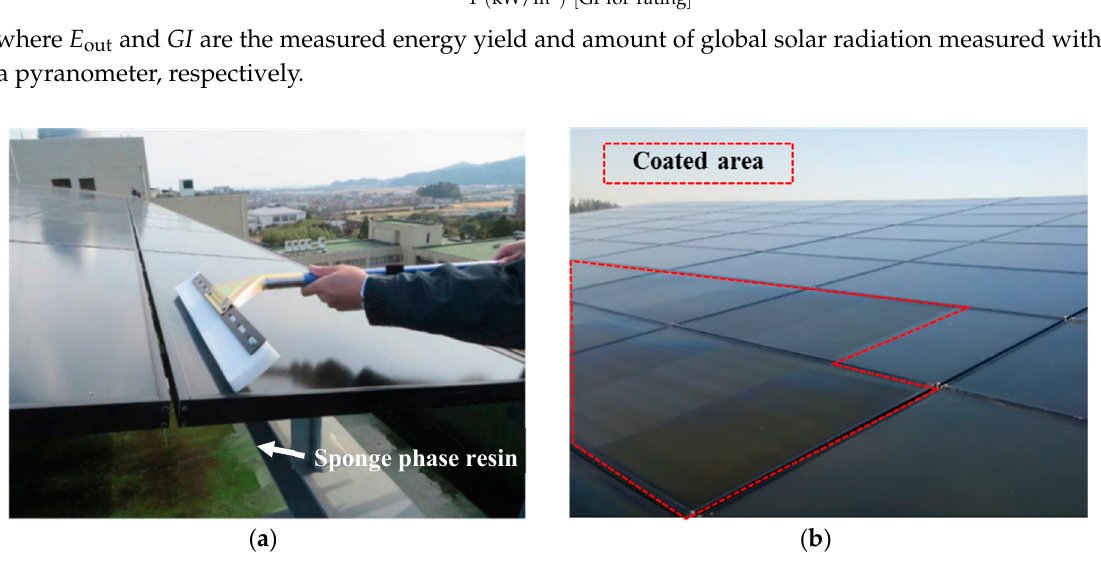
Figure 1. ( a ) Coating method using sponge phase resin; ( b ) surface of the PV modules.